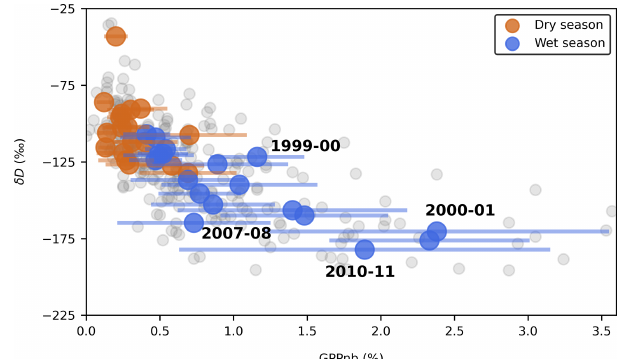
Figure 6. Seasonal mean GPPnb and δ D for the dry seasons (or- ange circle) and the wet season (blue circle). Error bars (horizontal bands) for GPPnb are based on the mean relative standard devia- tion for the samples integrating each season. Light gray dots in the background are raw data. The La Niña events discussed in the text